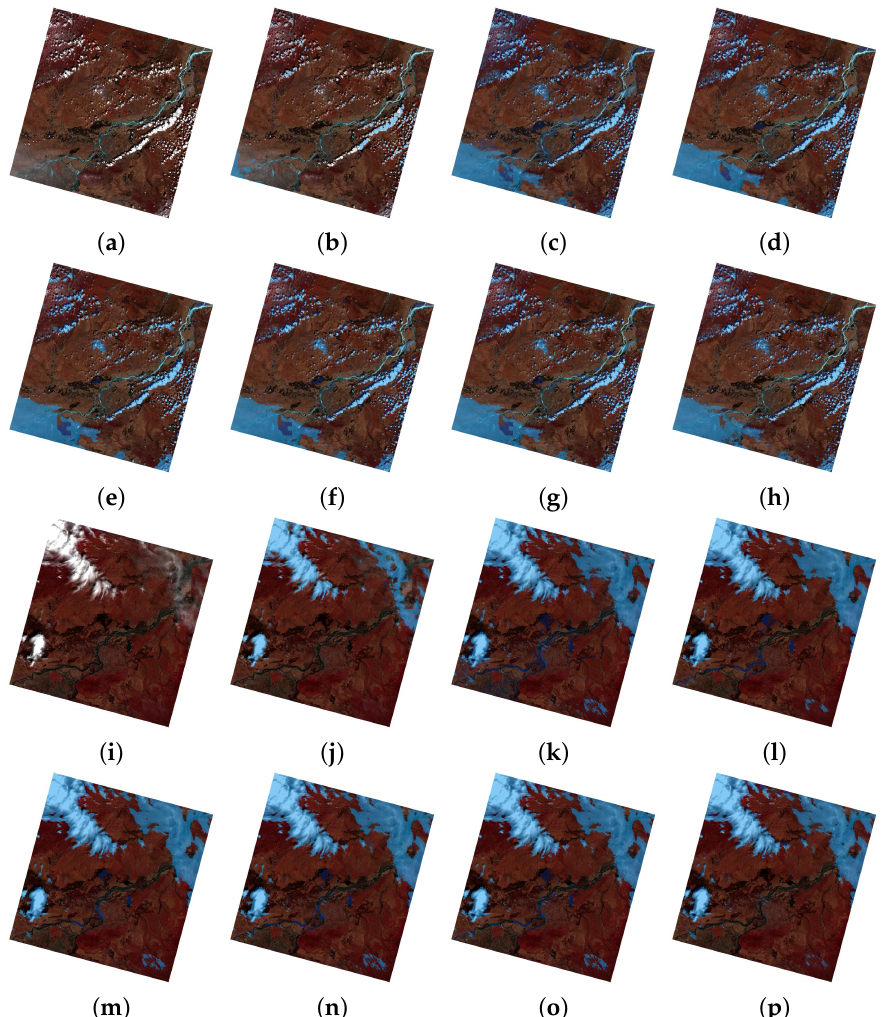
Figure 3. Typical visual examples of full images (1). ( a , i ) False-color (Bands 5 NIR, 4 Red, and 3 Green) images, ( b , j ) Reproduced PSPNet [1,31], ( c , k ) UNet × α [1], ( d , l ) Global Refined UNet [1], ( e , m ) Refined UNet v2 [2], ( f , n ) Refined UNet v3 [7], ( g , o ) Refined UNet v4, ( h , p ) QA reference.